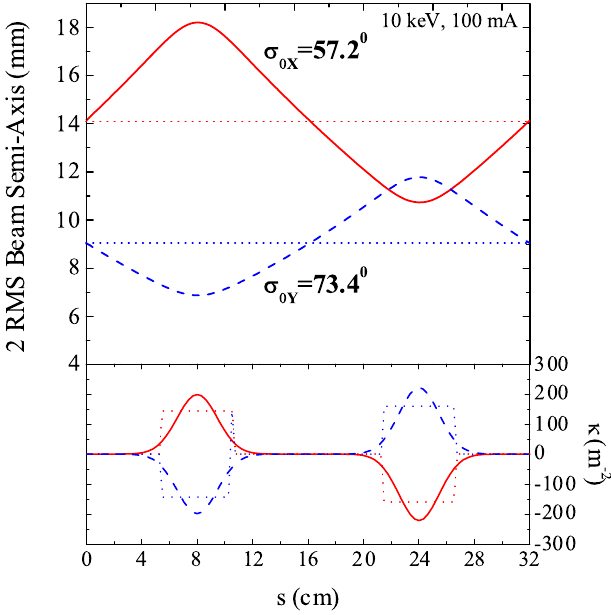
FIG. 6. (Color) Asymmetric FODO matching: beam envelopes (cid:5) 57 : 2 (cid:12) , (cid:5) (cid:5) 73 : 4 (cid:12) . Periodic-matched so- in UMER for (cid:5) 0 x 0 y lutions from the envelope code SPOT are shown for a extreme space-charge dominated beam (10 keV, 100 mA, 60 (cid:10) m -edge